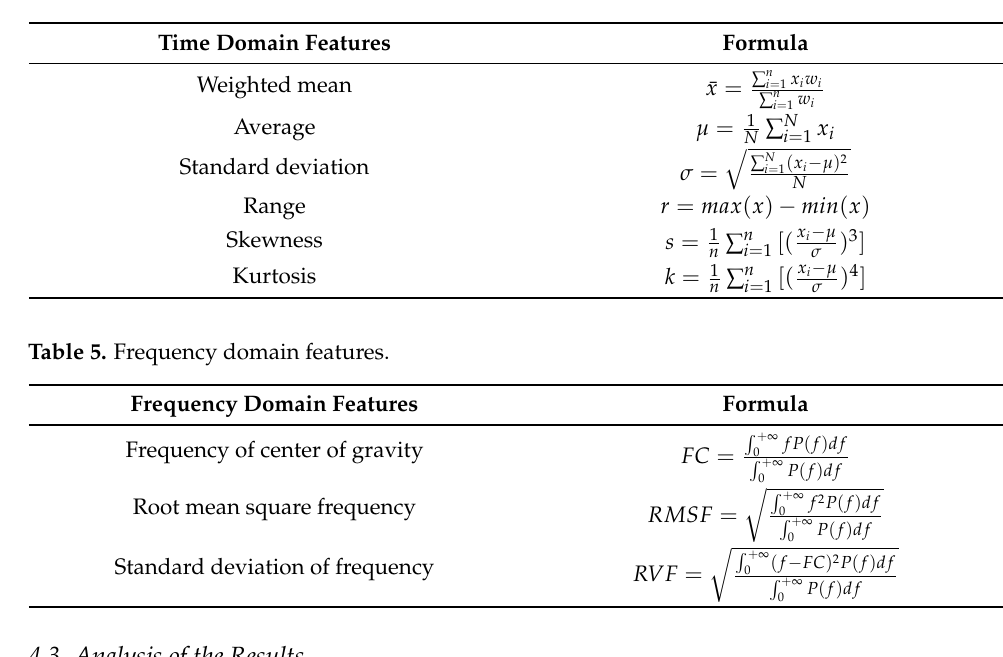
Figure 12. The effect of egg size on current signal. Table 4. Time domain features.